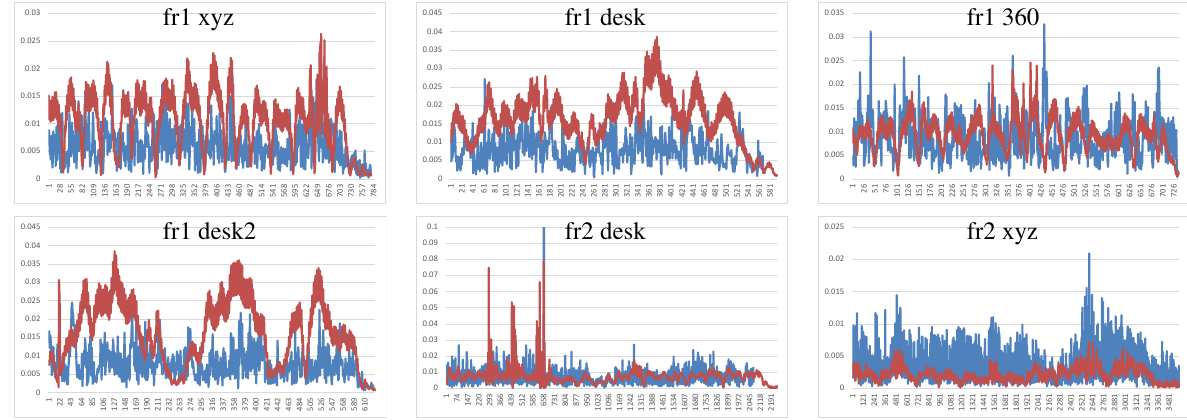
Figure 9. Visual features + ICP relative pose translational errors (y-axis, meters) on the selected datasets (x-axis,